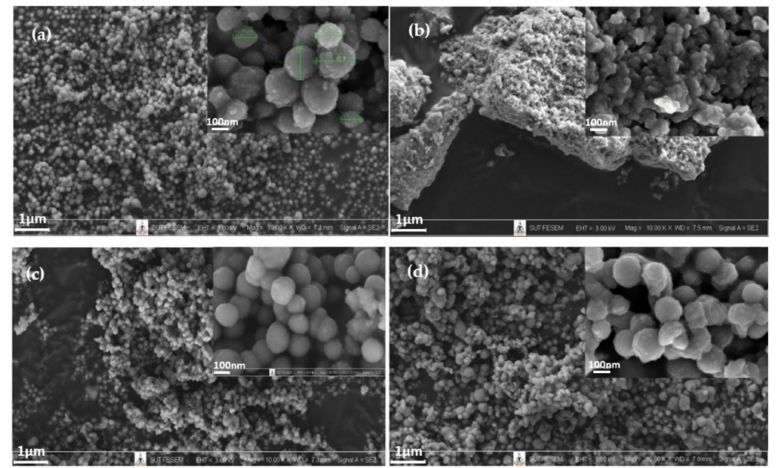
Figure 8. Low ( × 10k WD = 7.0–7.5 mm EHT = 3.00 kV) and high ( × 100k WD = 6.9–7.3 mm EHT = 3.00 kV) magnification SEM images of Ti 50 Si 50 oxides synthesized at various pH values: ( a ) SiO 2 , ( b ) Ti 50 Si 50 pH 8.0, ( c ) Ti 50 Si 50 pH 9.0, ( d ) Ti 50 Si 50 pH 10.0. XRD patterns of Ti 50 Si 50 oxide powders synthesized at various pH values (8.0, 9.0,